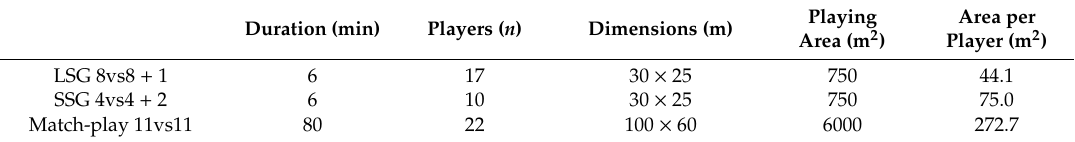
LSG = large-sided game; SSG: small-sided